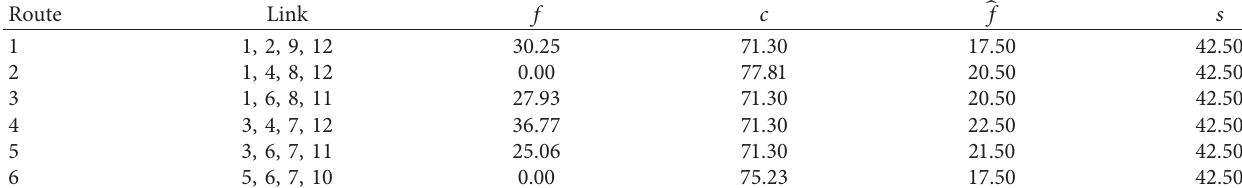
Table 3: Route flow, route travel cost, and surplus capacity in mixed equilibrium for travellers.